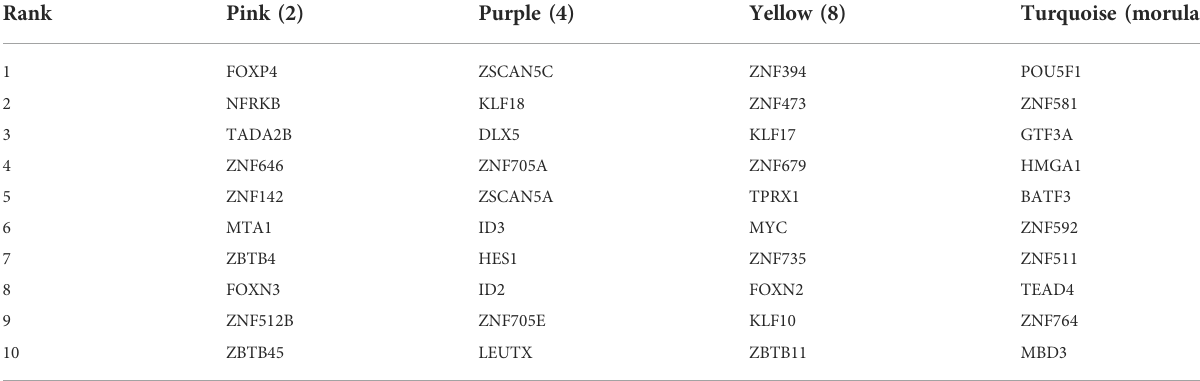
TABLE 1 Transcription factor with the highest connectivity within the signi fi cant module related to the